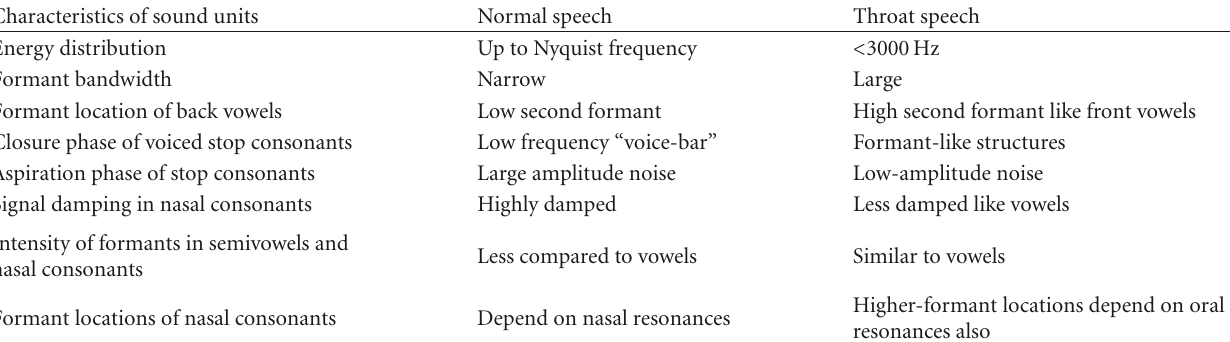
Table 1: Characteristics of sound units in TM speech and NM